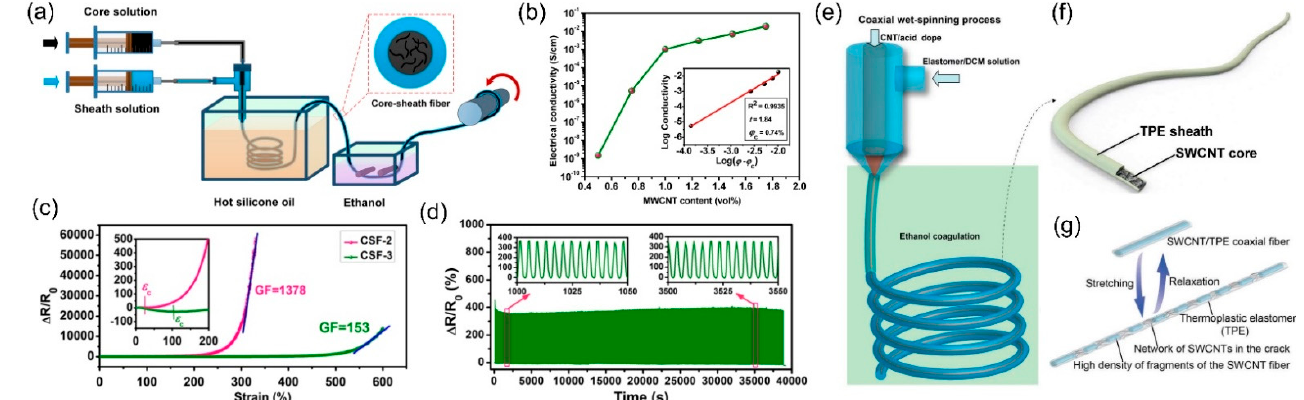
Figure 3. ( a ) Schematic of the coaxial spinning for the conductive coaxial fibers; ( b ) electrical con- ductivity of coaxial fibers as a function of volume fraction of CNT; ( c ) resistance change vs. applied strain with different concentration of CNT; ( d ) relative resistance change of fiber sensor under cyclic loading at 100%; Reprinted with permission from Ref. [66]. 2018, American Chemical Society. ( e ) schematic of the coaxial wet − spinning to produce the fi bers; ( f ) schematic illustration of the core– sheath structure of the fiber; and ( g ) schematic showing the fragmentation of the coaxial fiber during loading Reprinted with permission from Ref. [67]. 2018, Wiley − WCH.